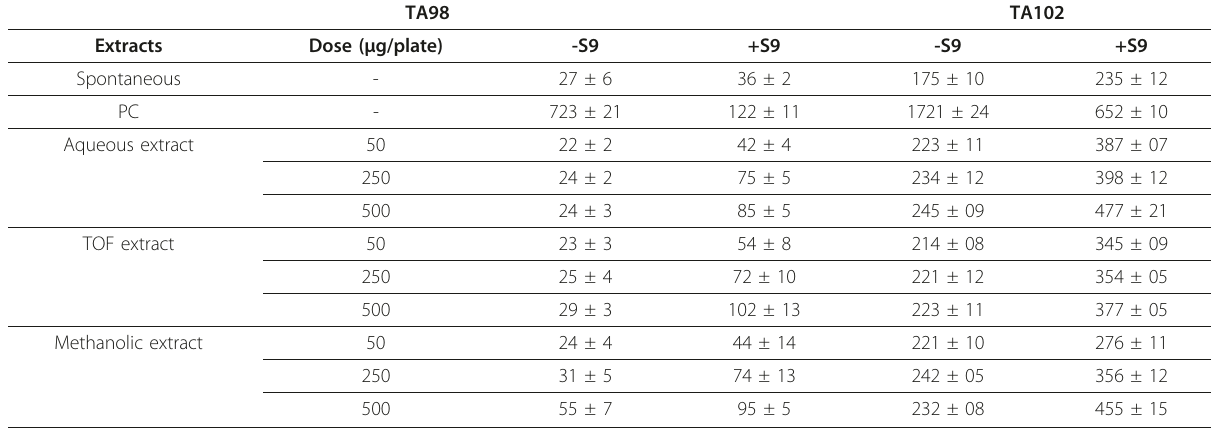
Positive control (PC): TA98/-S9, NOPD (10 μ g/plate); TA102/-S9, MMS (10 μ g/plate); TA98/+S9, B(a)P (7.5 μ g/plate); TA102/+S9, 2-AA (5 μ